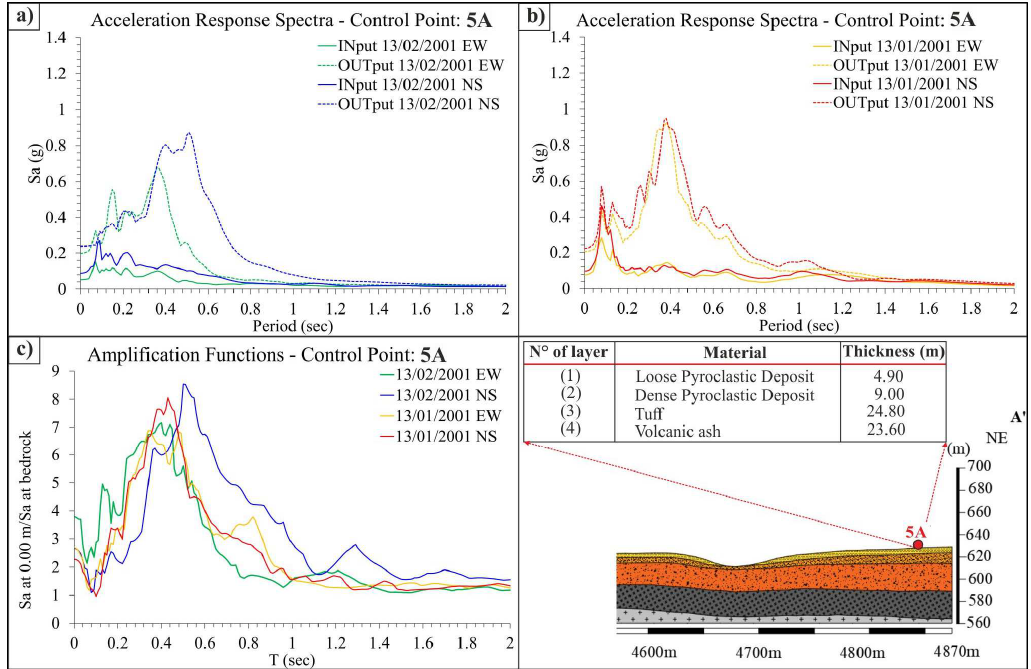
Figure 17. Section AA′: numerical control point 5A spectral responses obtained by 2D numerical analyses using LSR2D software. ( a ) Comparison among the SA of the two components of the 13 February 2001 earthquake. ( b ) Comparison among SA of the two components of the 13 January 2001 earthquake. ( c ) Amplification functions related to the four input motions.